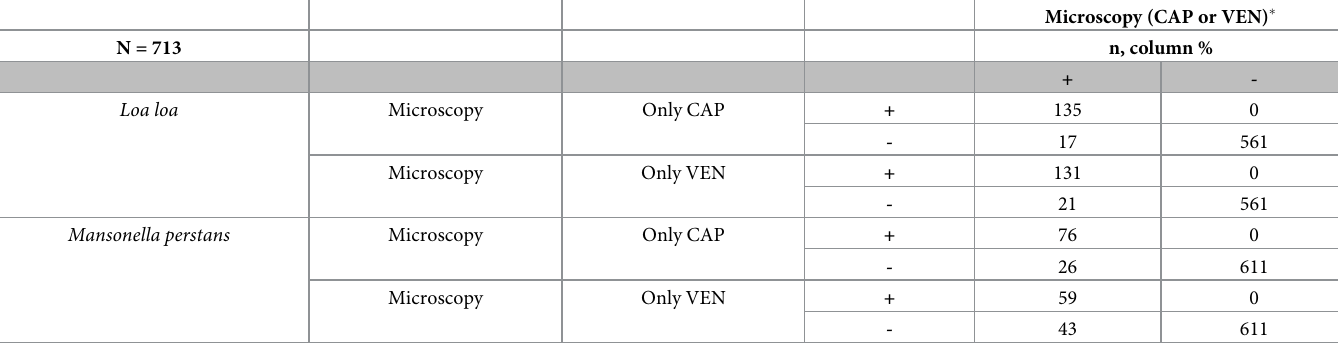
Table 5. Crosstabulation of capillary and venous microfilaraemia versus a light microscopy gold-standard.